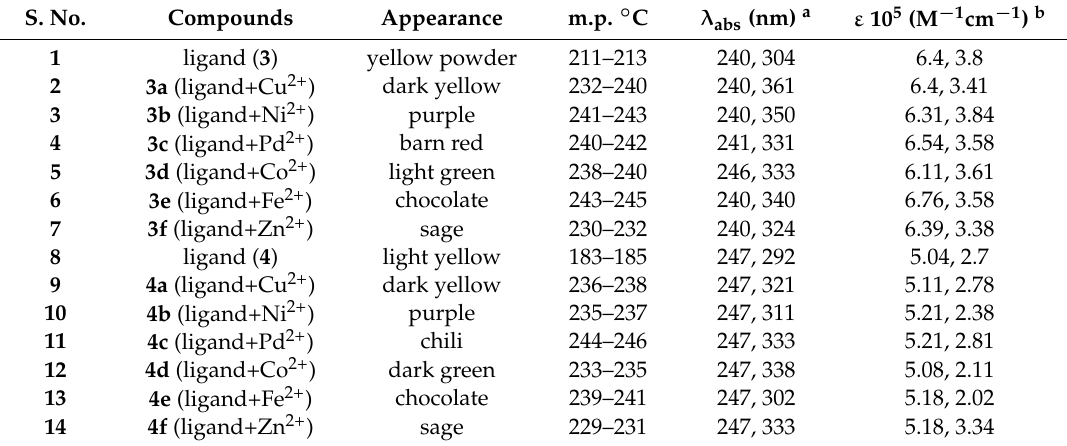
Physical characteristics and optical analysis results for ligands 3 and 4 before and after